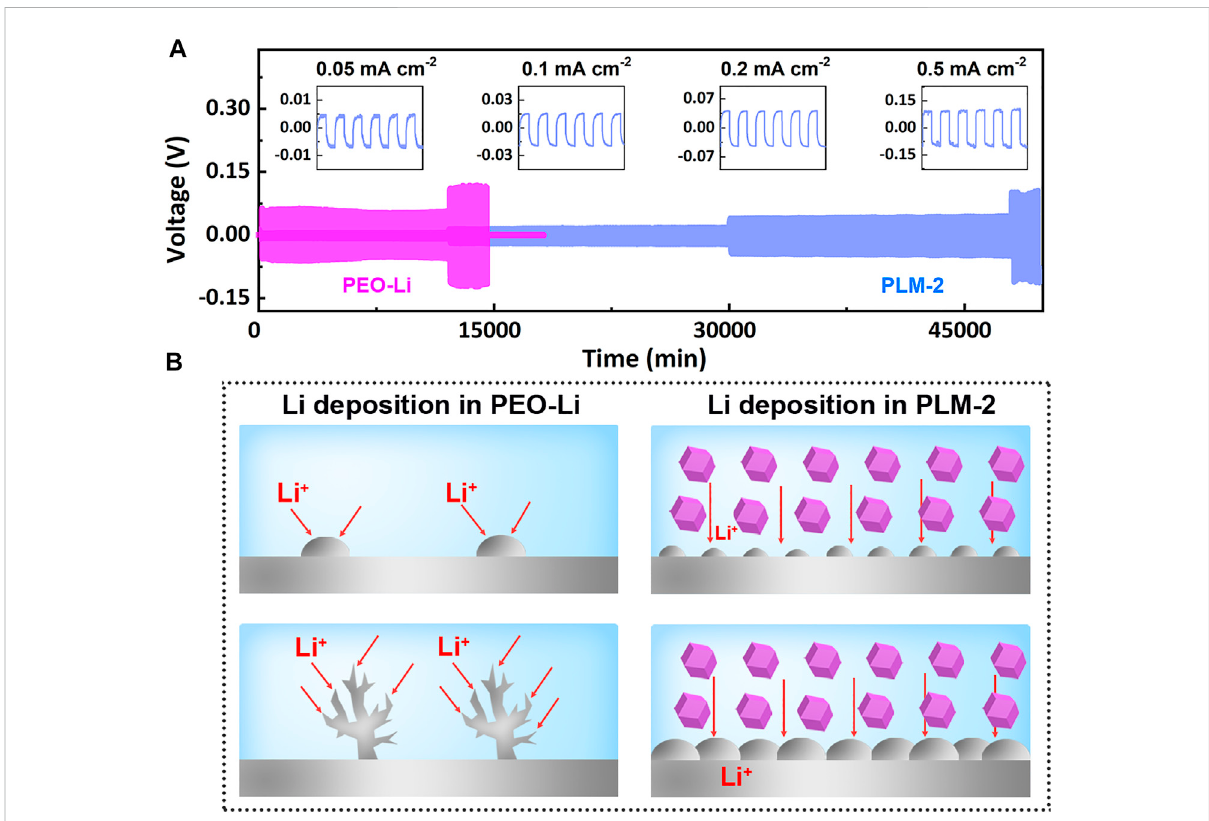
FIGURE 3 (A) The galvanostatic cycling of Li/PLM-2/Li symmetric cell and Li/PEO-Li/Li cell at 60 ° C. (B) Illustration of PLM-2 in suppressing Li dendrite